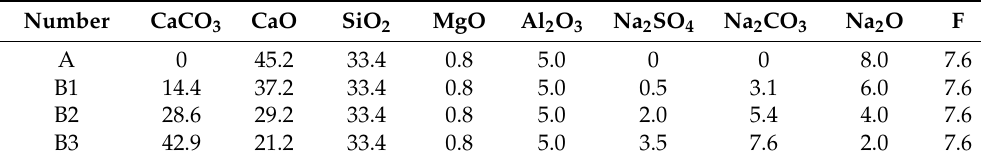
Table 1. Chemical compositions of mold fluxes (wt%).